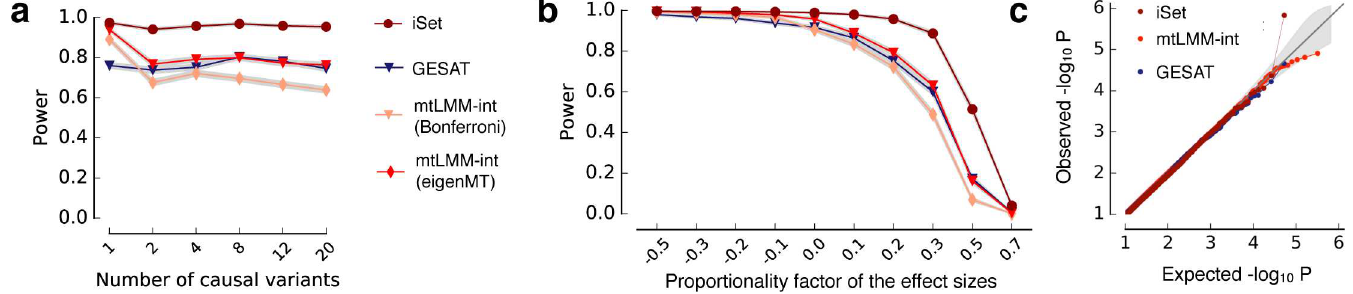
Fig 5. Application of iSet to stratified designs. (a,b) Power comparisonof iSet and alternative methods using simulateddata where each individual is phenotyped in one of two contexts. Shownis a comparisonof power for alternativemethods. (a) Power to detect interactionswhen simulatingrescaling- GxC for increasing numbersof causal variants. (b) Power when varying the factor of proportionality of the variant effect sizes betweencontexts. Considered were iSet, a single-variant interactiontest (mtLMM-int, [10]) as well as the interaction sequencekernel associationtest (GESAT, [13]), a set test designed for stratified populations. For single-variant models, two alternative approachesto adjust for multipletesting were considered (Bonferroni, eigenMT). (c) QQ-plot of P values from genotype-sex interactiontests for C-reactive protein levels using individualsfrom the Northern FinlandBirth Cohort [20], consideringthe same